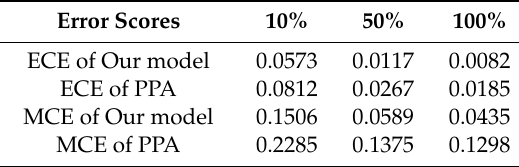
Table 8. Comparison of error scores using different amounts of training data.